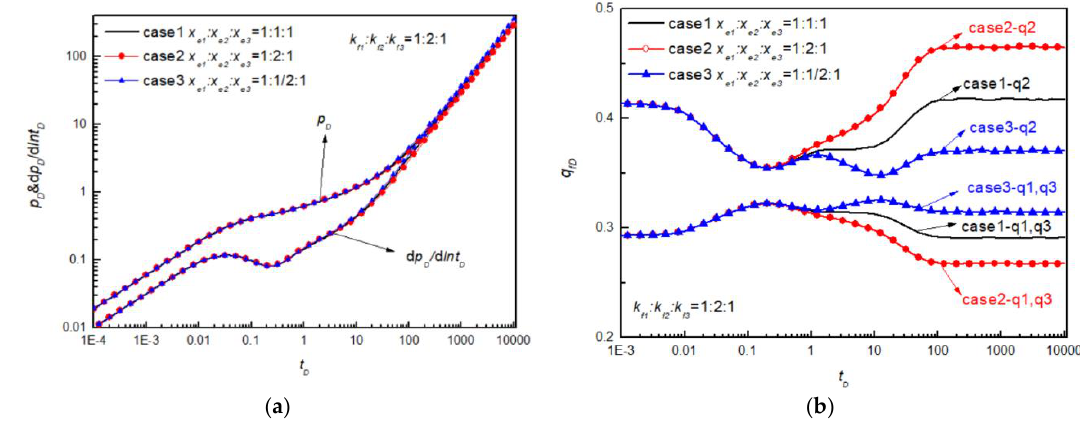
Figure 6. Pressure response and flux distribution of non-uniform length distribution. ( a ) Pressure and pressure derivative; ( b ) Flux distribution of each hydraulic fracture.